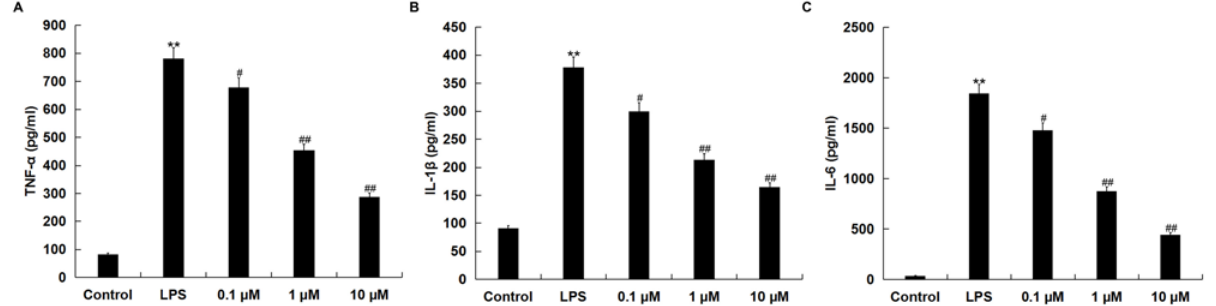
Figure 2. Effects of NGR1 on pro-inflammatory cytokine production in LPS-treated RAW264.7 cells. In addition to an untreated control sample, RAW264.7 cells were pretreated with concentrations of NGR1 (0.1, 1, and 10 µ M) for 2 h and then treated with 1 µ g/ml LPS at 37˚C for 24 h. The levels of TNF-α, IL-1β, and IL-6 in the culture supernatants of RAW264.7 macrophages were then detected by ELISA. Data were presented as the mean ± SD. **p<0.01 vs. control group; #, ## p<0.05, 0.01 vs. LPS treatment alone